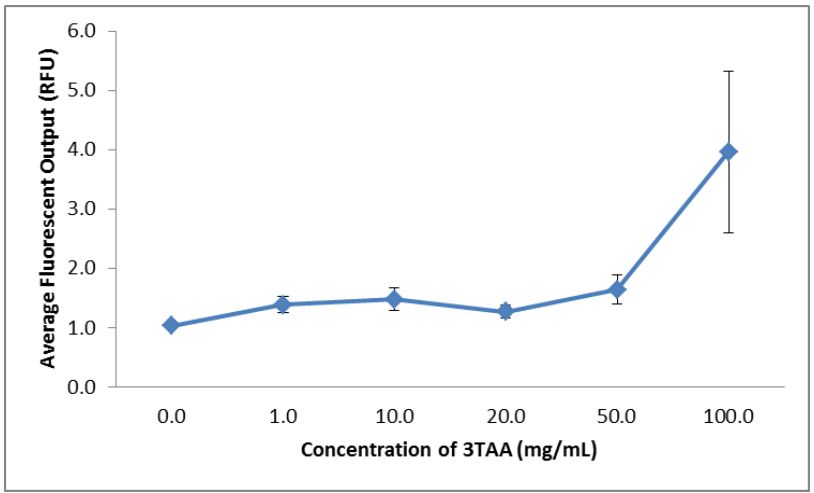
Figure 5. Change in average fluorescent output after FITC-avidin binding based on increasing 3TAA concentrations with error bars showing the standard error of the mean for each sample. The overall trend shows the average fluorescence output increasing at larger concentrations of